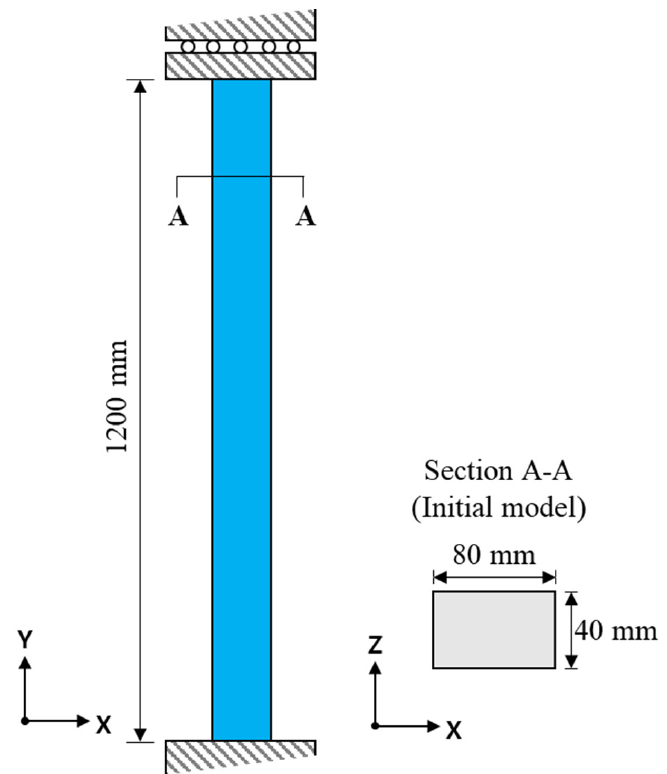
Figure 2. Initial geometry of the proposed damper.